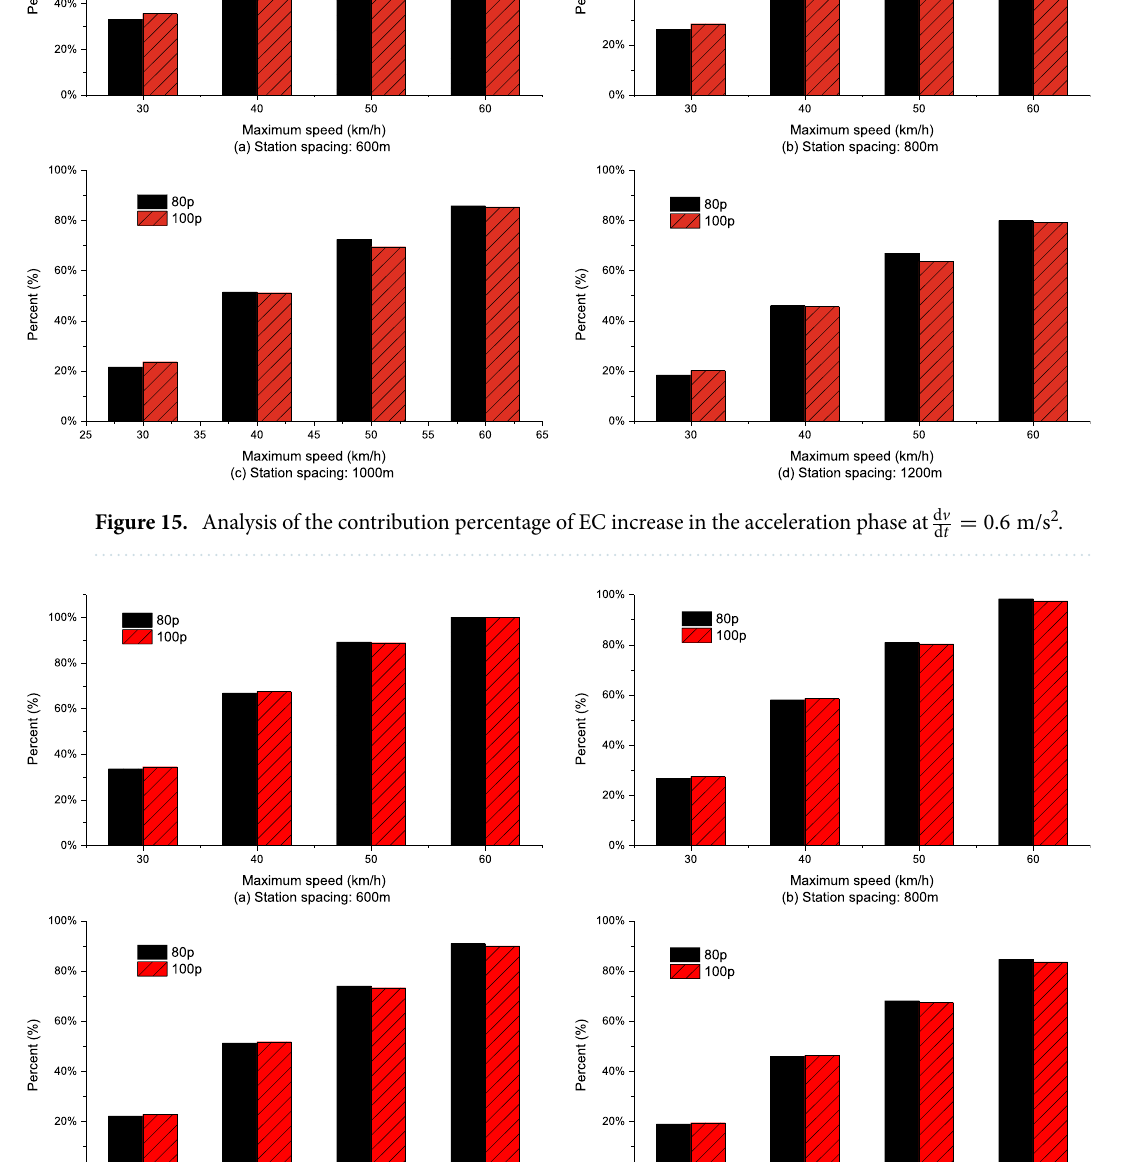
Figure 16. Analysis of the contribution percentage of EC increase in the acceleration phase at d